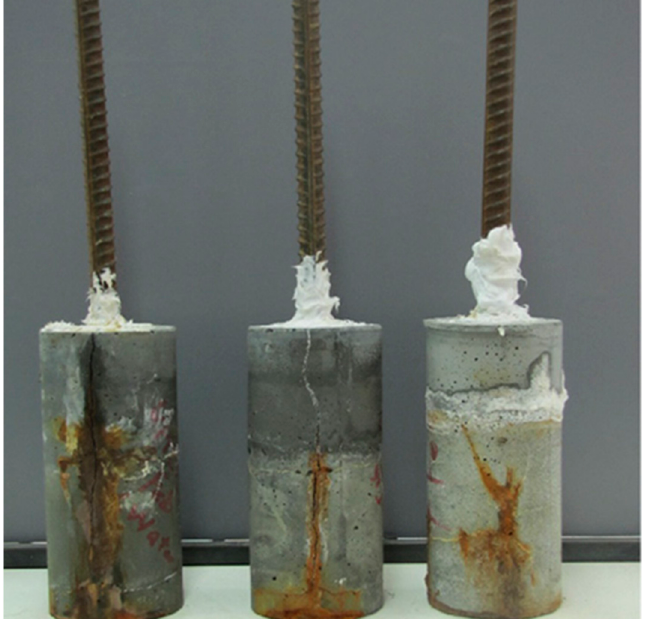
Figure 4. Cracked reinforced UHPC using accelerated-corrosion test Reprinted/adapted with per- mission from [107]. 2023, Cement and Concrete Composites.